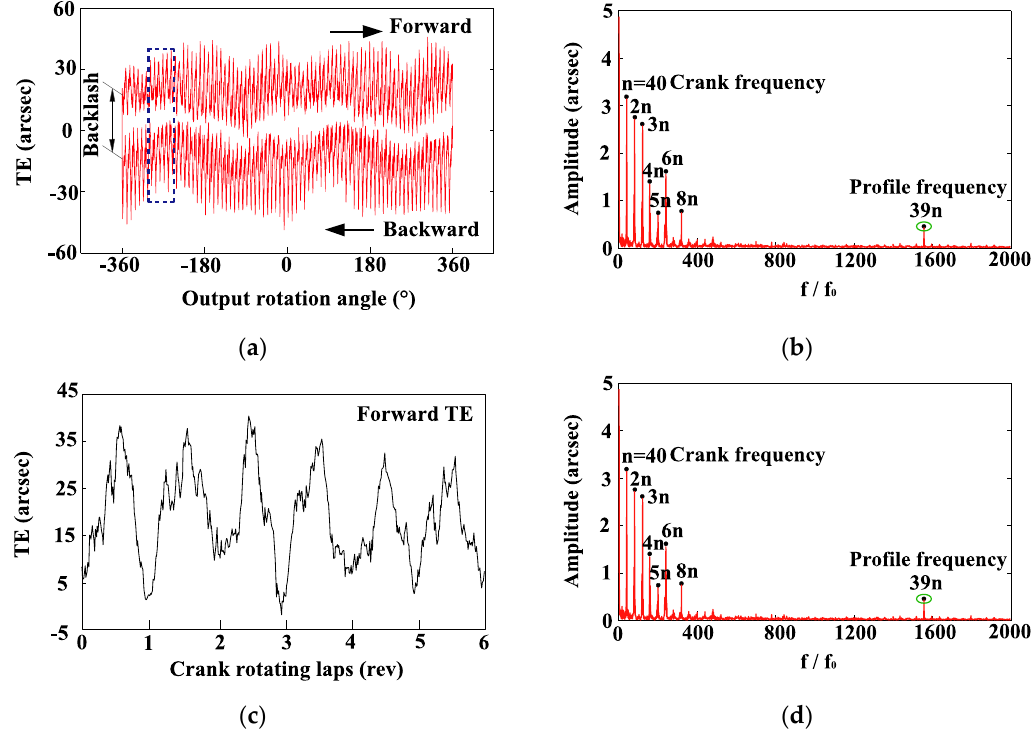
Figure 10. Test results of RV prototype: ( a ) transmission error (TE) including backlash, ( b ) harmonic spectrum of a TE as output shaft rotates one round, ( c ) enlarged view of forward TE in the dashed frame of ( a ), and ( d ) enlarged view of backward TE in the dashed frame of ( a ).